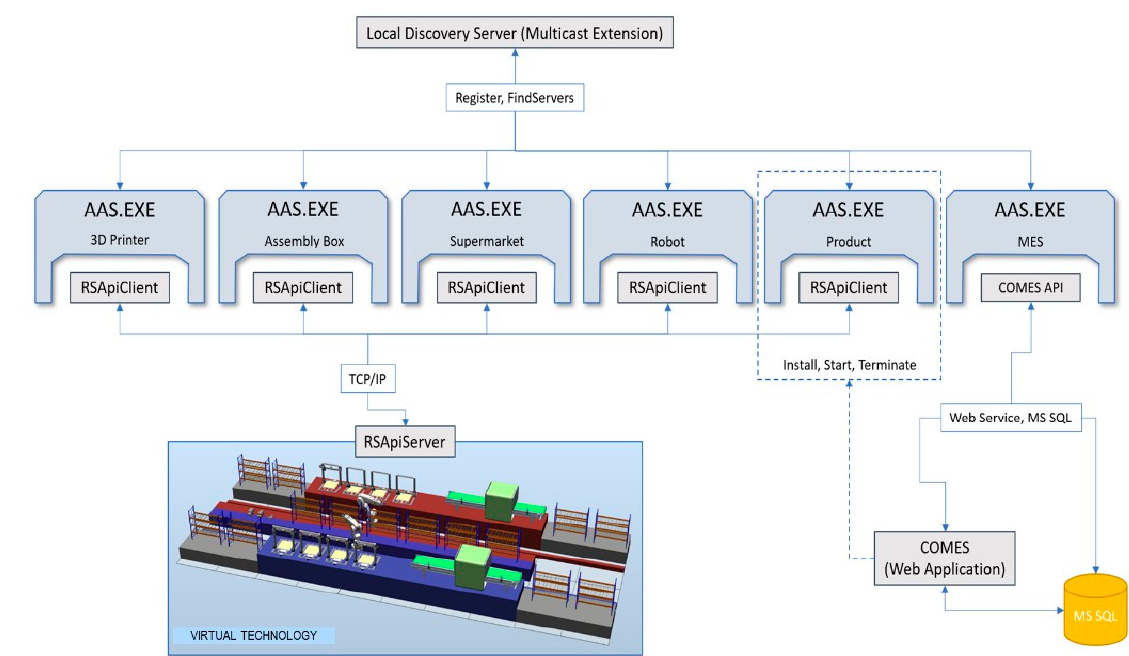
Figure 6. The architecture of the presented case study.